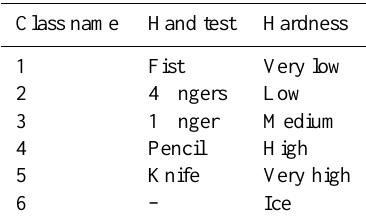
Table 2. Nomination of classes of subjective hardness, adopted from Colbeck et al.